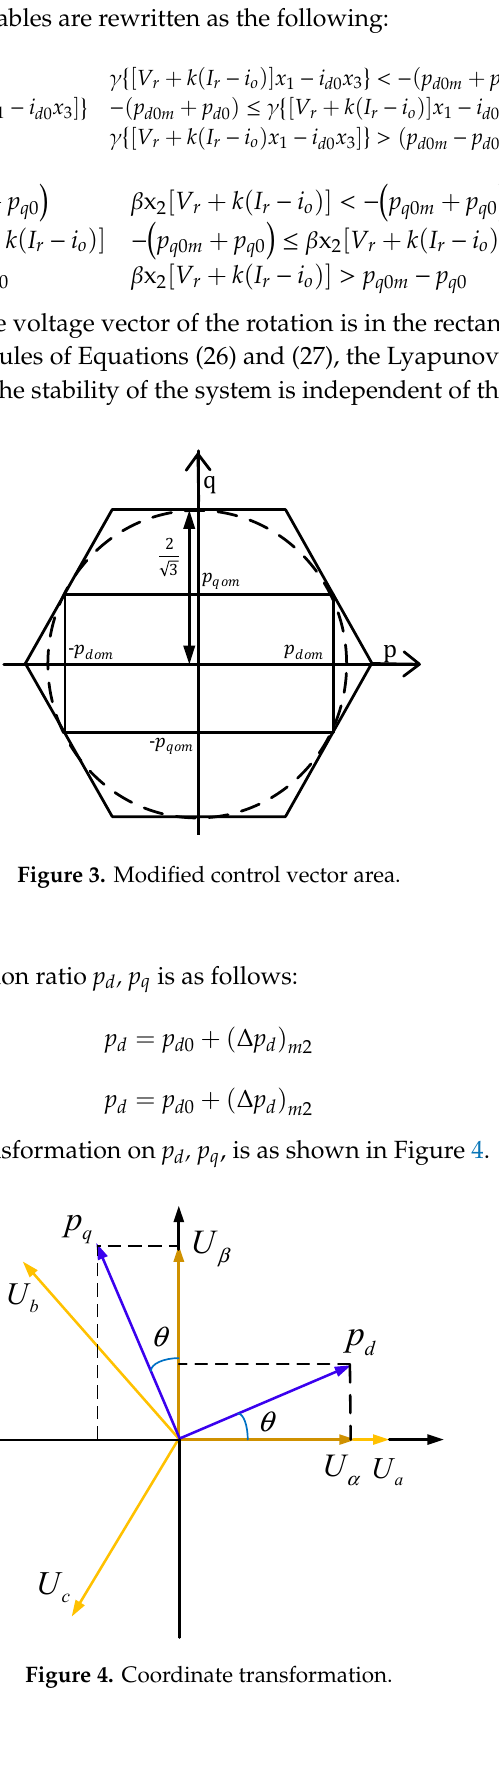
Figure 4. Coordinate transformation. Here, p d and p q are inversely transformed into U α and U β , and the electrical angle θ is taken as the angle. Then, p d and p q are respectively vector-decomposed, and the voltage components on the α - axis and the β -axis are calculated as follows: